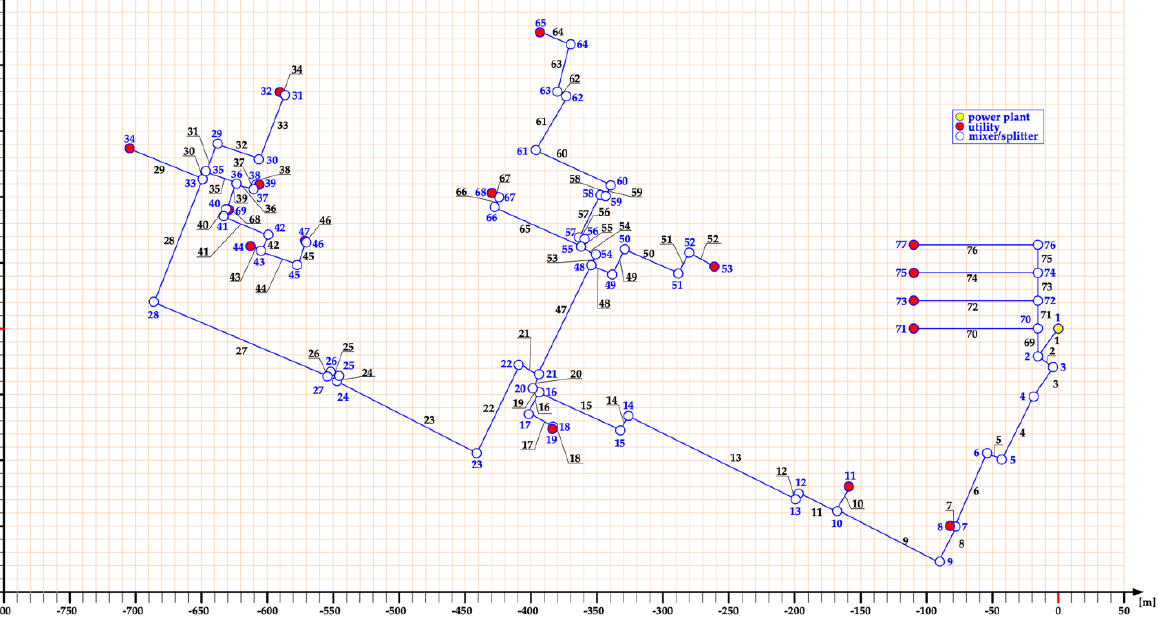
Figure A1. Network topology [25].